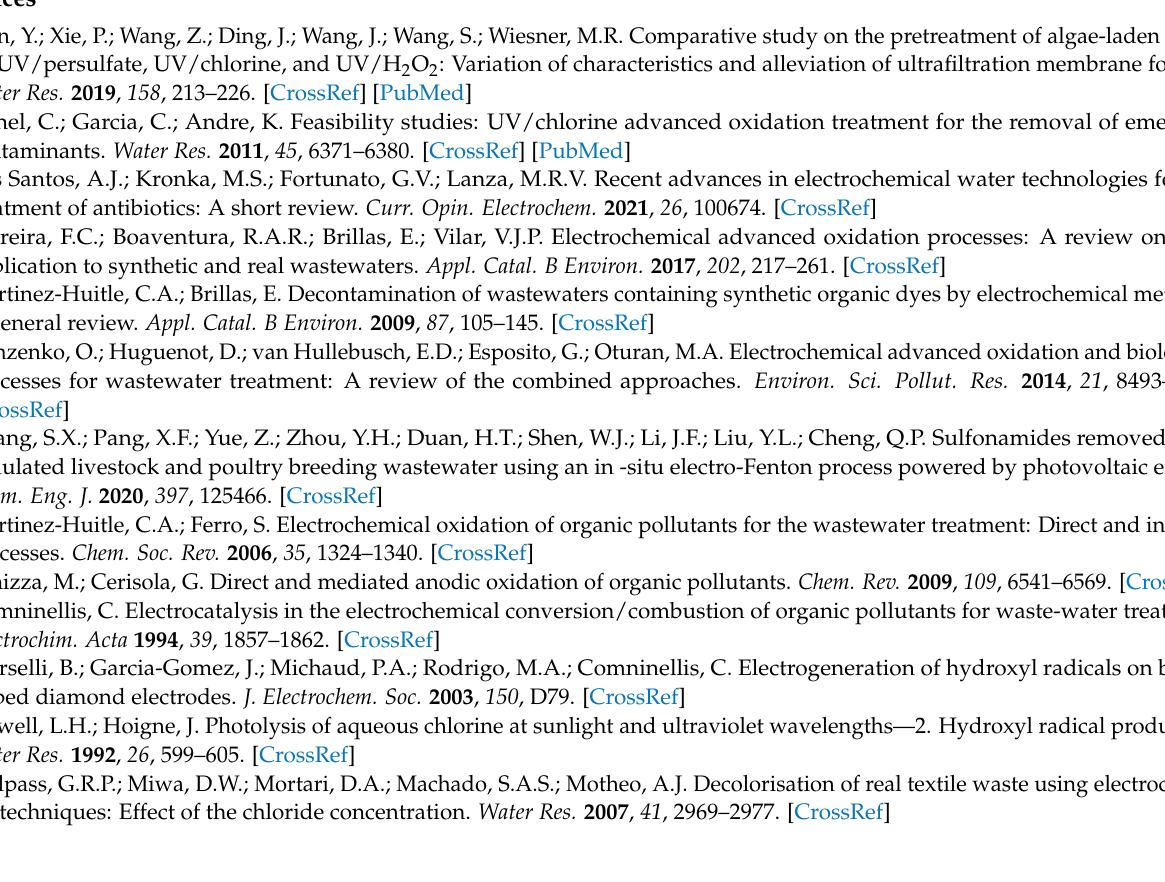
Figure A2. UV-vis absorption spectra of sulfonamides at various pH (the concentrations of sulfon- amides were measured in 10 µ mol/L, and the measured absorbance value was deducted from the absorbance value of deionized water).